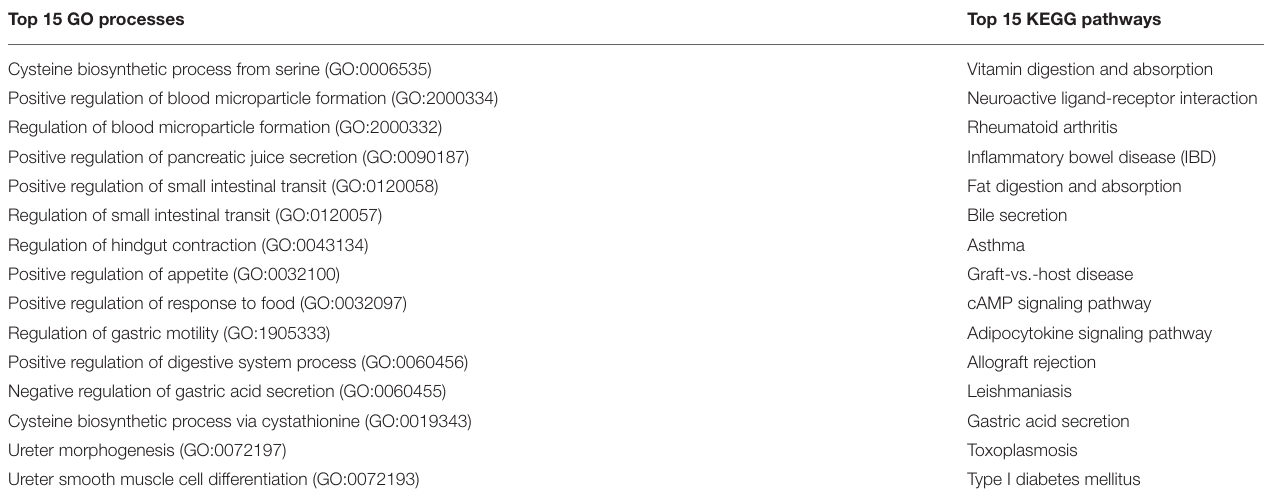
TABLE 7 | Top 15 GO processes and KEGG pathways related to the selected 99 gut-immune genes involved in extracellular digestion. Top 15 GO